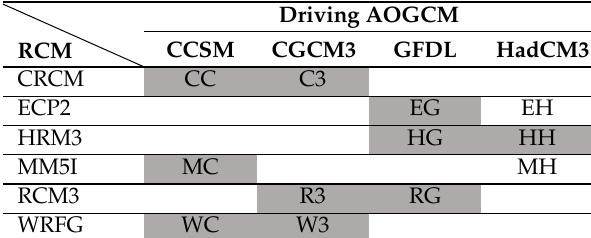
Table 1. The NARCCAP Phase II models. Models utilized in this paper are shaded with abbreviation. Driving AOGCM CCSM CGCM3 RCM